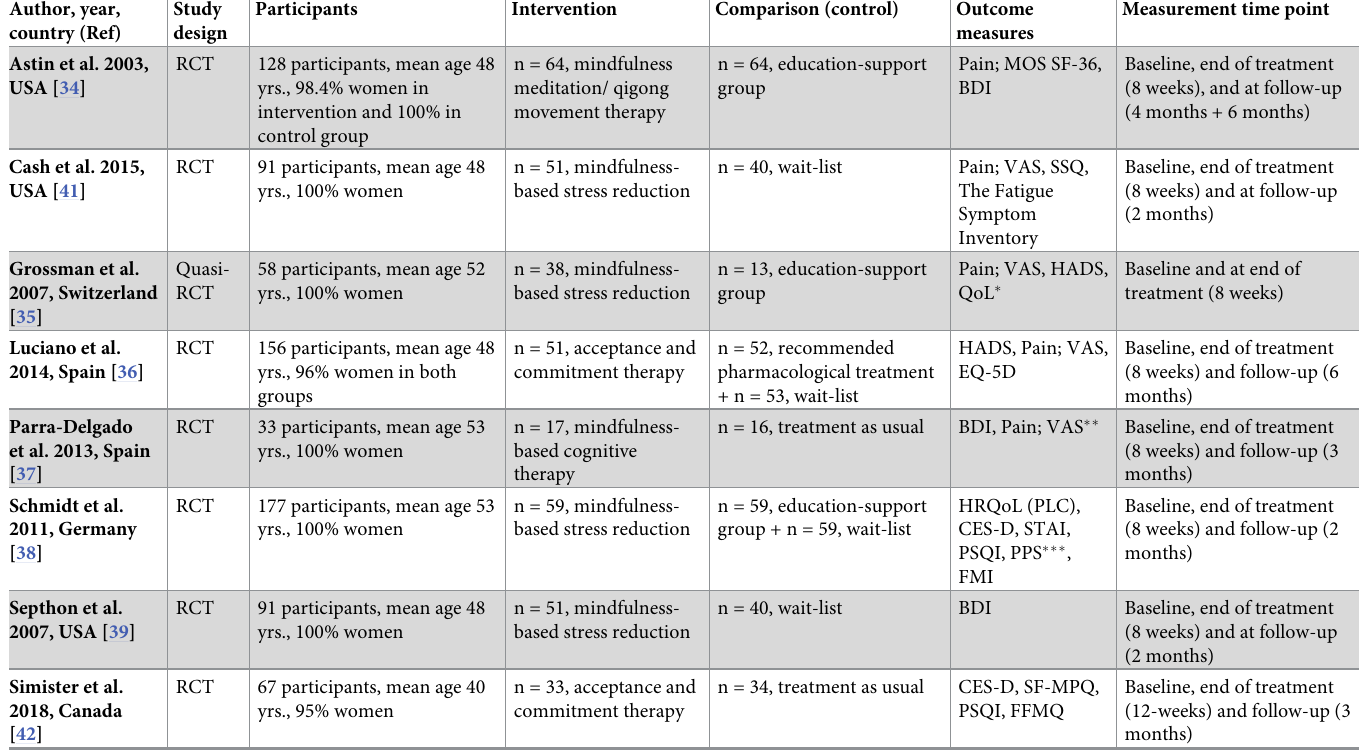
Table 1. Characteristics of included studies (n =